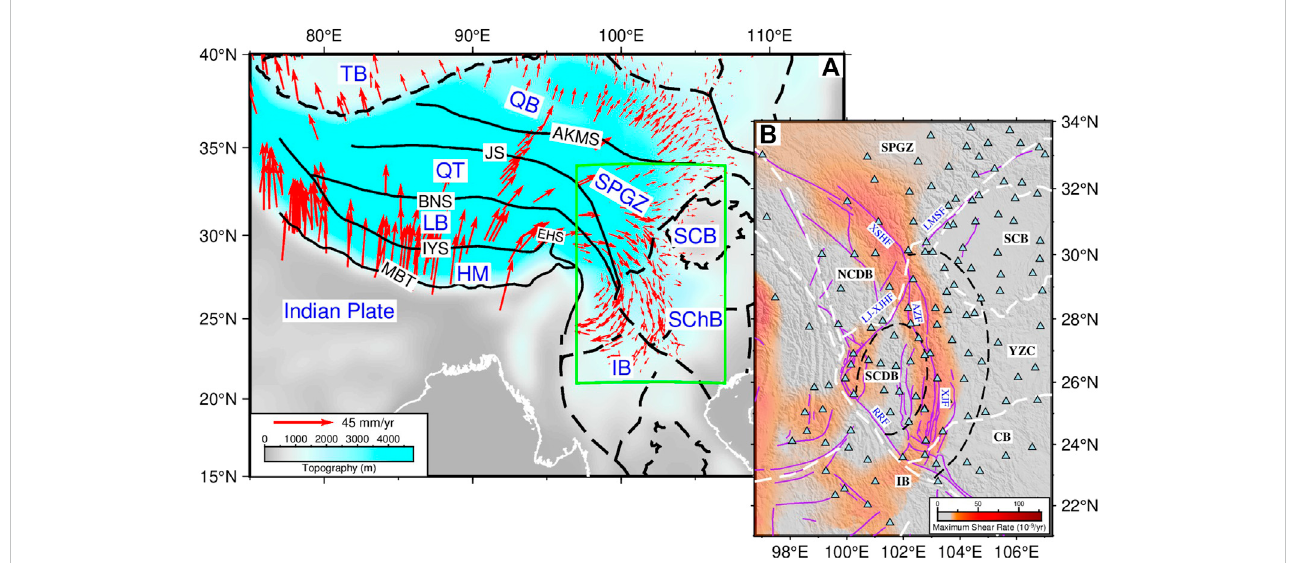
FIGURE 1 (A) Geological setting in the Tibetan Plateau. The red arrows exhibit the GPS velocity measurements with respect to a stable Eurasia plate from Zhang et al. (2004). The green box denotes the study area. (B) Station map and geological setting in the southeastern Tibetan Plateau. Light blue triangles mark the distribution of stations. The background color shows the maximum shear rate (modi fi ed from Wang and Shen, 2020). Purple lines mark faults: LMSF, Longmenshan Fault; LJ-XJHF, Lijiang-Xiaojinhe Fault; AZF, Anninghe-Zemuhe Fault; XJF, Xiaojiang Fault; RRF, Red River Fault. The black and white lines represent the suture or block boundary. AKMS, Ayimaqin-Kunlun-Muztagh Suture; JS, Jinsha Suture; BNS, Bangong-Nujiang Suture; IYS, Indus-Yarlung Zangbo Suture; EHS, Eastern Himalayan Syntaxis; MBT, Main Himalayan Thrust. TB, Tarim Basin; QB, Qaidam Basin; QT, Qiantang Terrane; LB, Lhasa Terrane; HM, Himalayan Block; SPGZ, Songpan-Ganzi Terrane; SChB, South China Block; SCB, Sichuan Basin; NCDB, North Chuan-Dian Block; SCDB, South Chuan- Dian Block; YZC, Yangtze Craton; CB, Cathaysia Block; IB, Indochina Block. Black dashed lines mark the inner and intermediate zones of the Emeishan large igneous province (Xu et al., 2004).